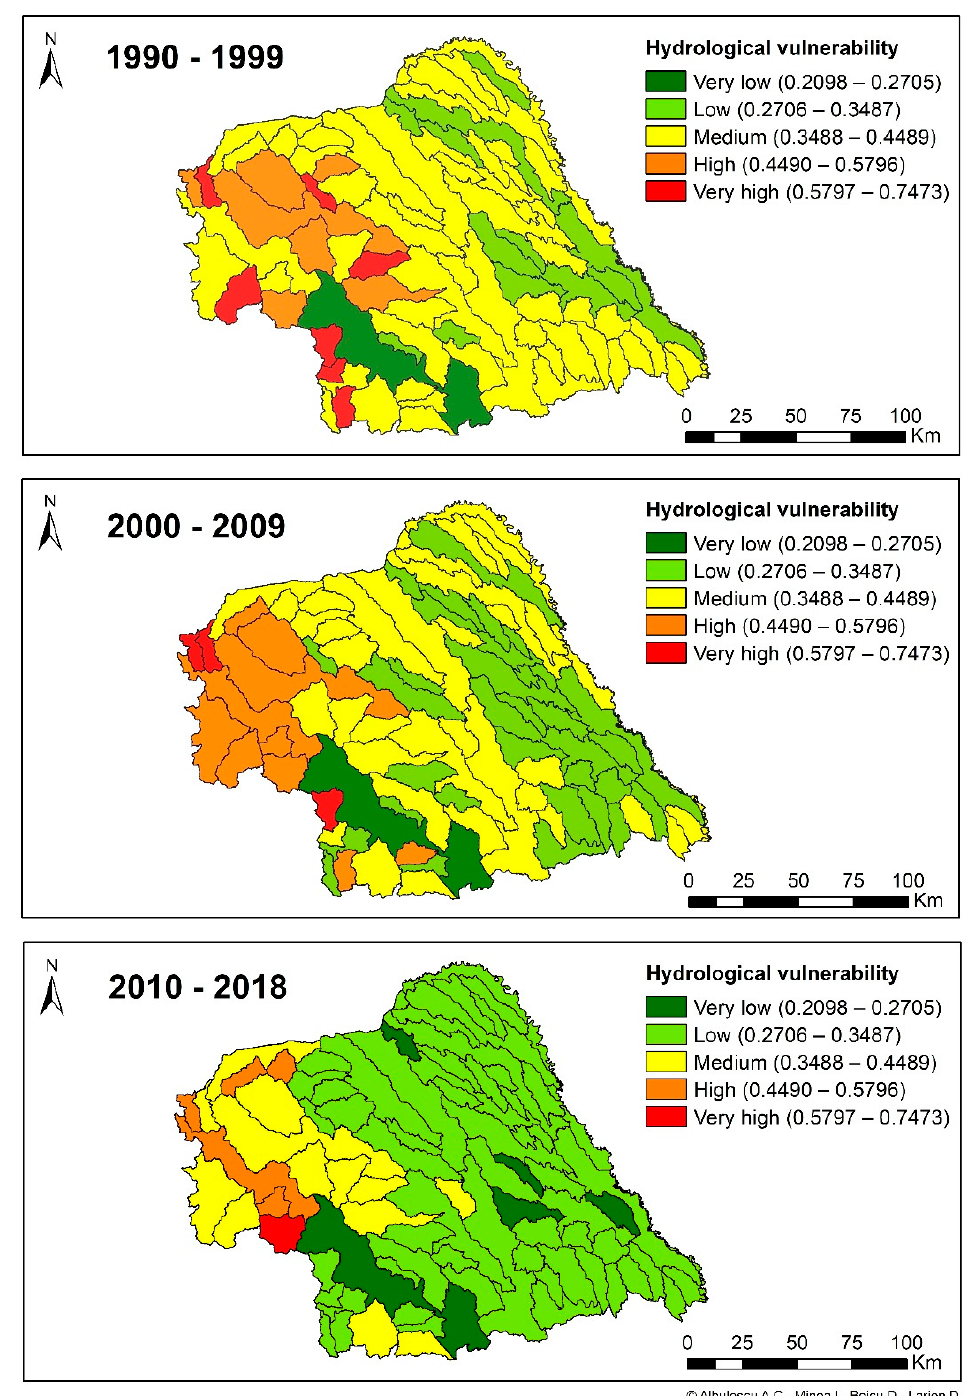
Figure 8. The evolution of the hydrological vulnerability level in the study area in 1990–2018.